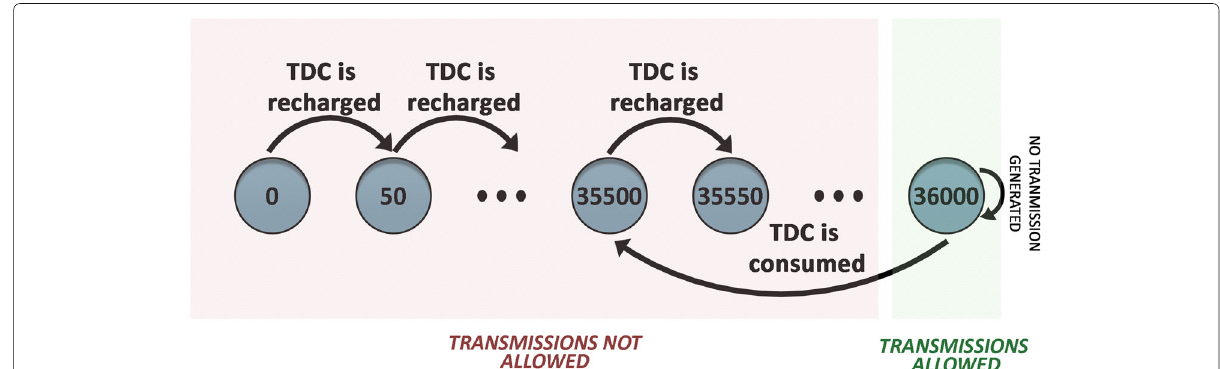
Fig. 2 Markovian model of TDC. Markovian model for the TDC consumption/recharge scheme. A sensing cycle of T = 5s, a DC of 1%, and a T ON = 0.5s have been considered in this representation. States indicate the stored TDC, expressed in milliseconds. When the node has enough TDC to transmit (that is, it is in a transmittable state where TDC = TDC MAX ), transmissions are allowed (denoted in green). Otherwise, transmissions are not allowed (denoted in red)